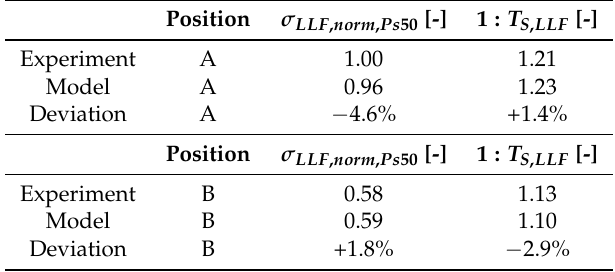
Figure 20. Probabilities of survival for investigated specimen positions A and B. Table 4. Validation of the fatigue assessment model in the long-life region (LLF).